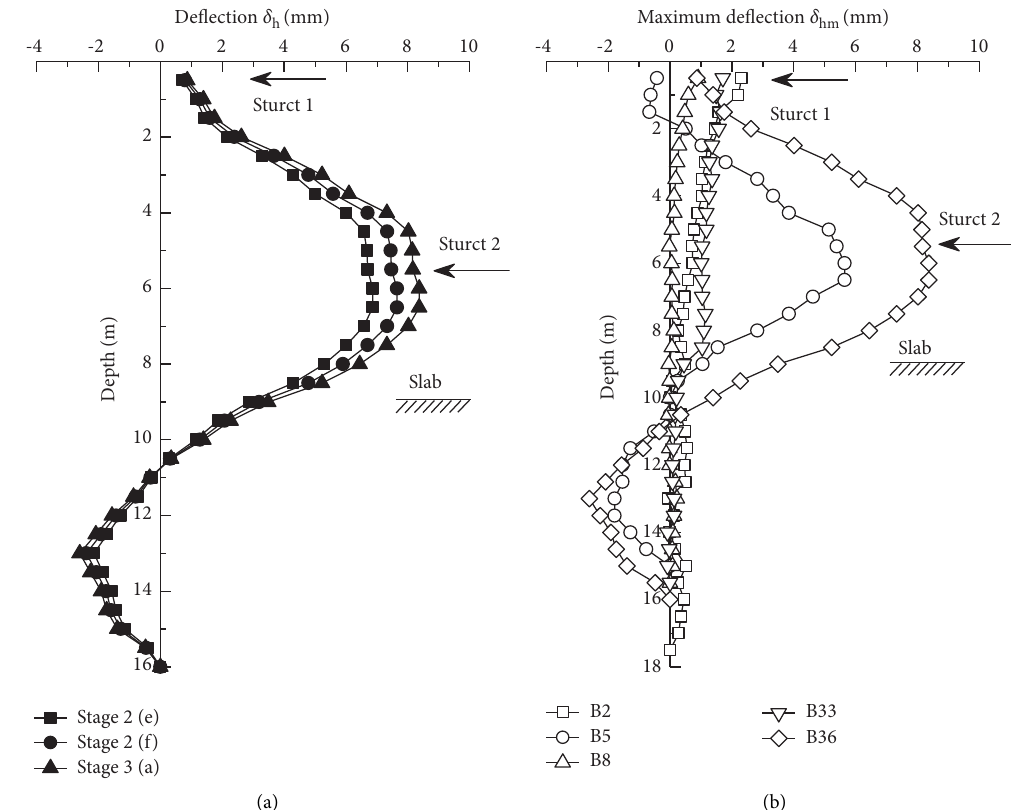
Figure 12: Lateral deflection of bored piles along depth. (a) Development of deflections at B36 and (b) maximum deflections at B2, B5, B8, B33, and B36.